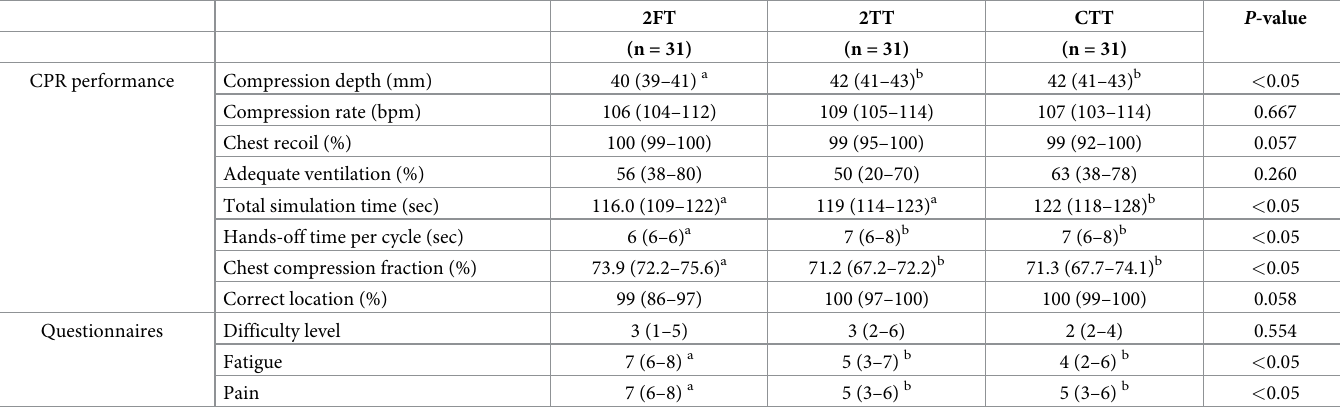
Table 2. Cardiopulmonary resuscitation performance and subjective feedback (NRS) in three